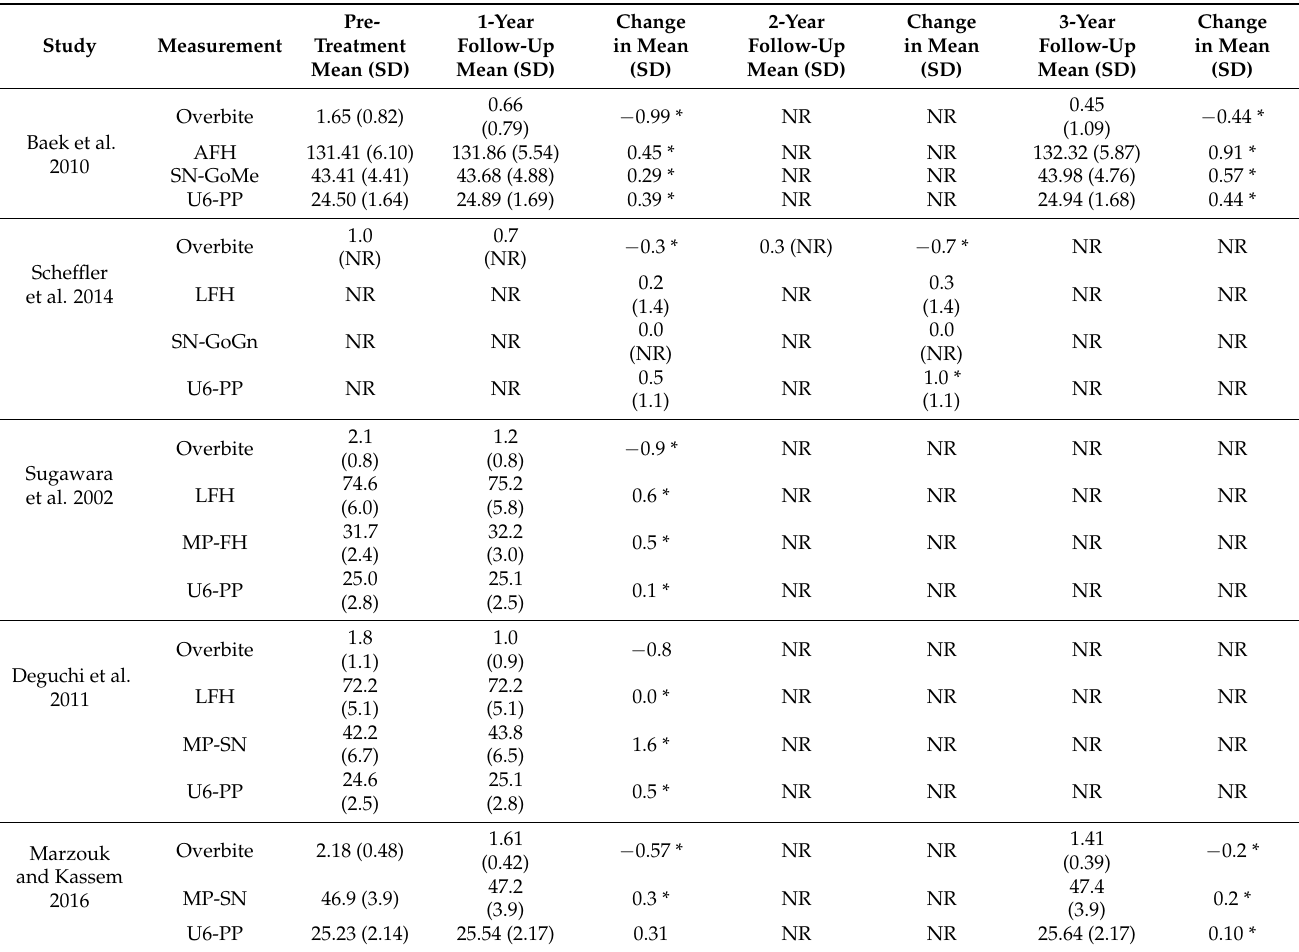
Table 14. Changes in selected values characterizing stability of results of AOB treatment by molar intrusion using skeletal